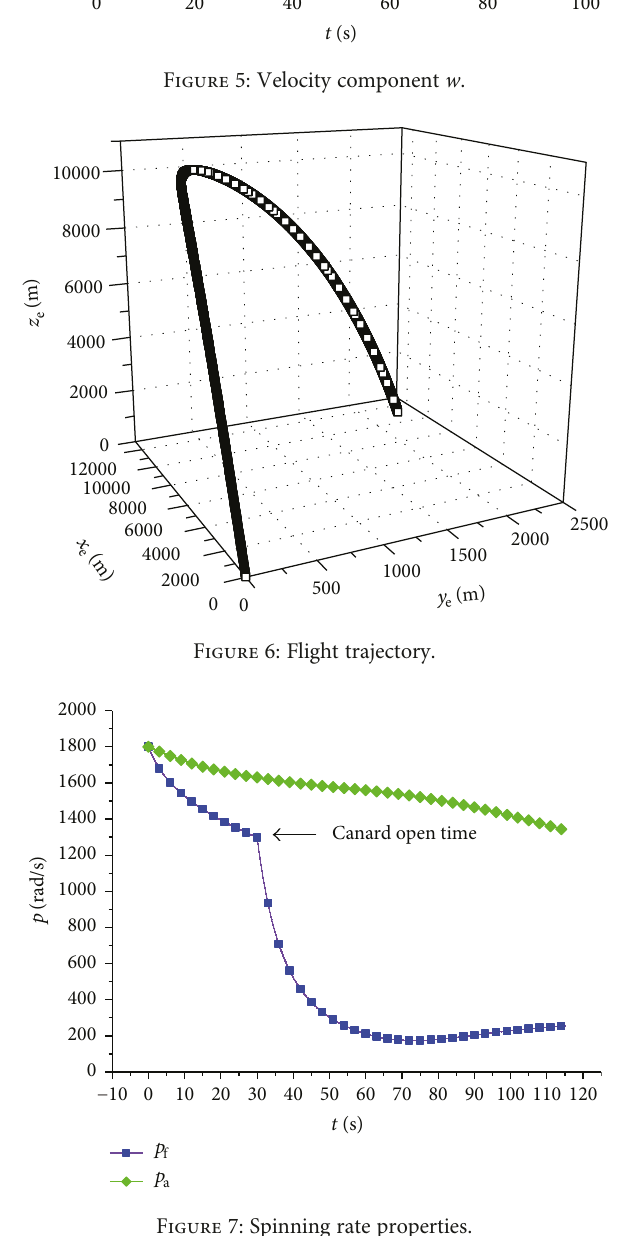
Figure 7: Spinning rate